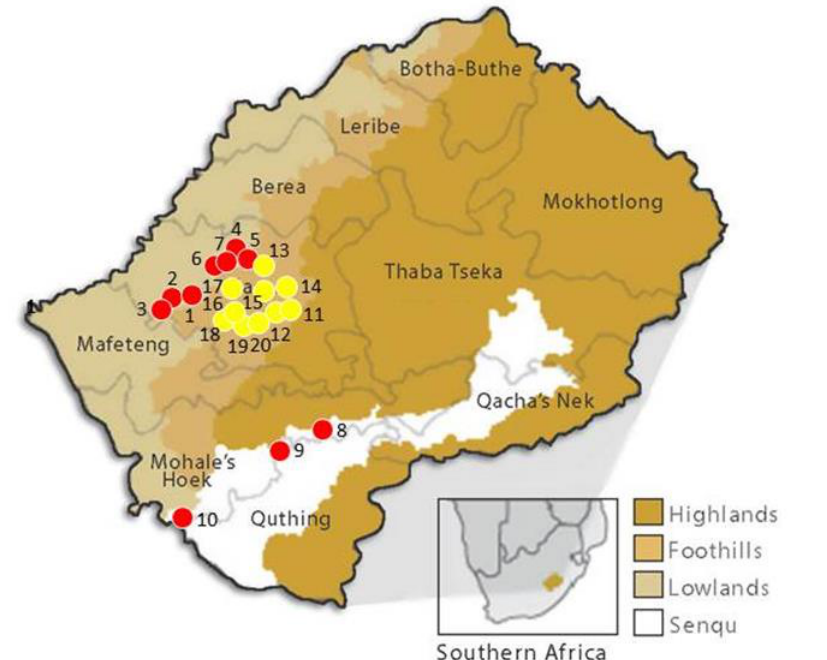
Fig. 1. Map of Lesotho showing ecozones and administrative districts. Study plots in lowlands are indicated with red dots, those in foothills – with yellow dots (number as in Table